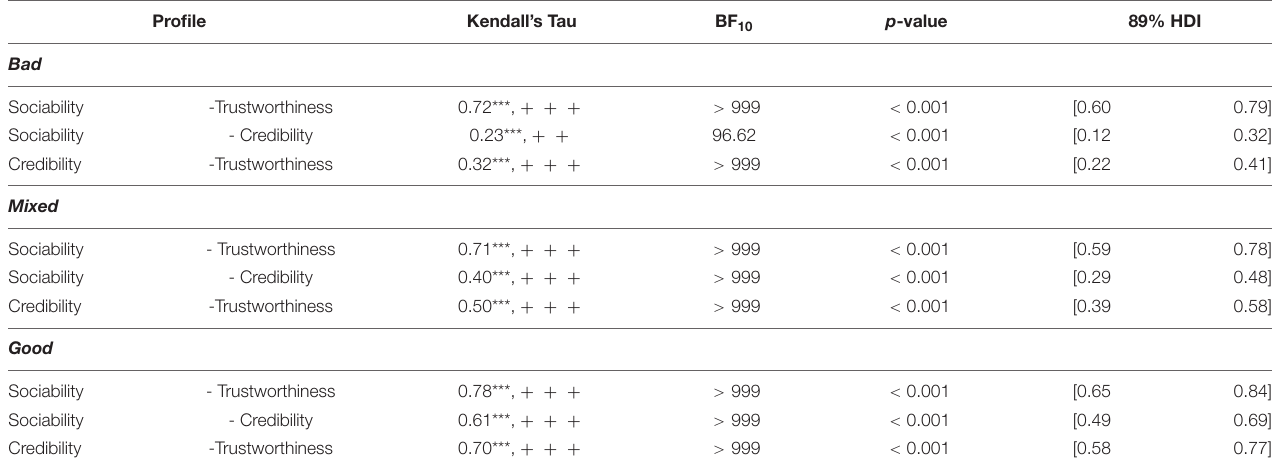
TABLE 8 | Correlations Between Perception of Hosts Measures for Each Profile